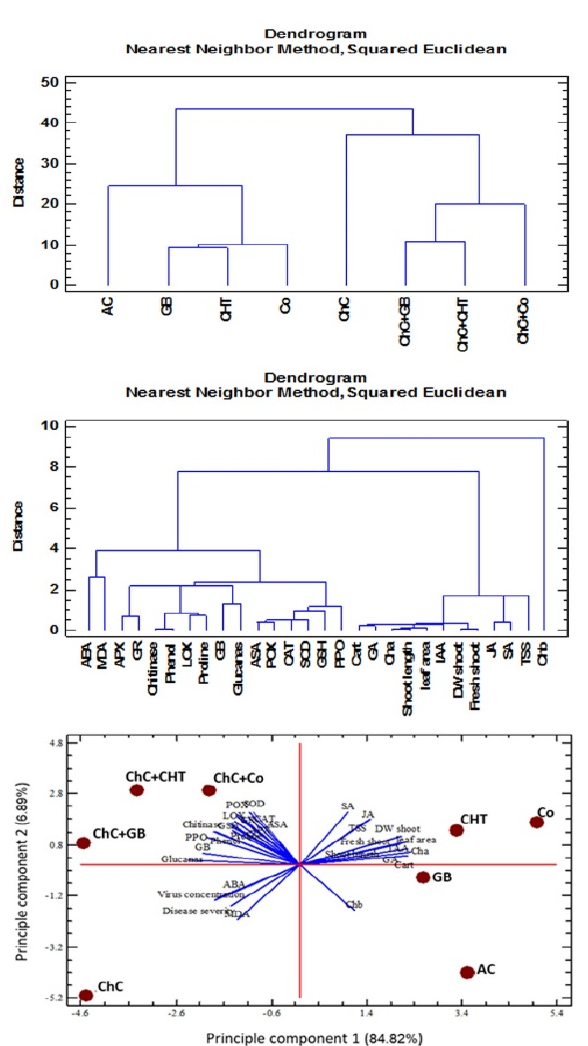
Figure 9. Hierarchical clustering (HCA) and principle component analysis (PCA) loading plot for glycine betaine (GB), chitosan (CHT) and combination (Co) treatment application under control and virus infection (ChC) generated by Statgraphics XVII software Version 17.20. ABA: abscisic acid; APX: ascorbate peroxidase; ASA: ascorbic acid; Cart: carotenoids; CAT: catalase; GA 3 : gibberellic acid; GB: glycine betaine; GR: glutathione reductase; GSH: glutathione; IAA: indole acetic acid; JA: jasmonic acid; LOX: lipoxygenase; MDA: malondialdehyde; POX: peroxidase; PPO: polyphenol oxidase; SA: salicylic acid; SOD: superoxide dismutase; TSS: total soluble sugars.